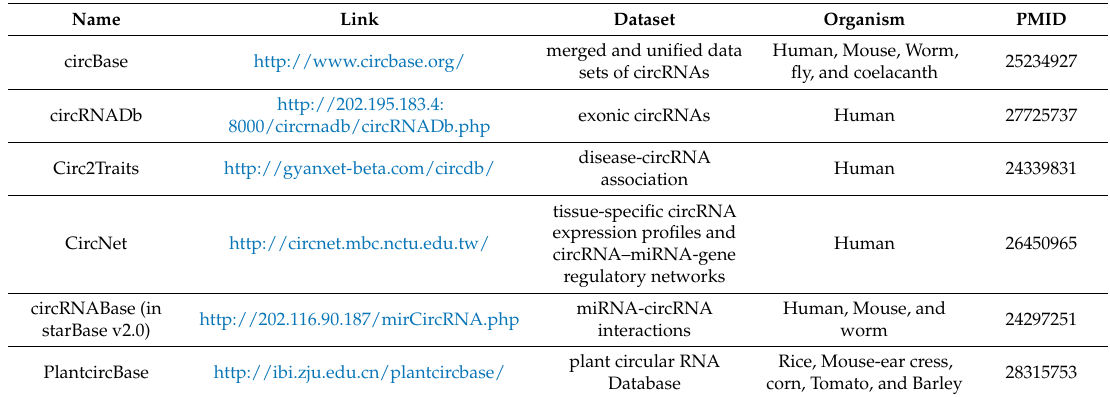
Table 3. circRNA